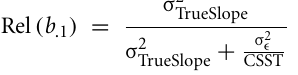
FIGURE 6 | Illustration of the reliability of ordinary least squares slope parameter estimates and its dependency on the corrected sum of squares of time variable (CSST). Non-linear functions depict the expected increase of reliability with CSST for different ratios r = 1/ h of (error variance)/(true slope variance) for h = 1, 2, ... , 10.The vertical lines indicate values of CSST for one, two, three, and four annual follow-up measurements in a longitudinal MRI